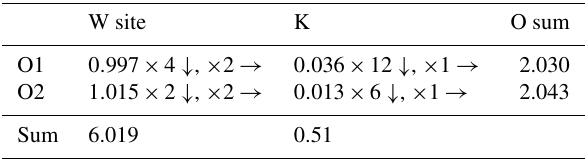
Table 6. Selected bond lengths (Å) in wumuite.